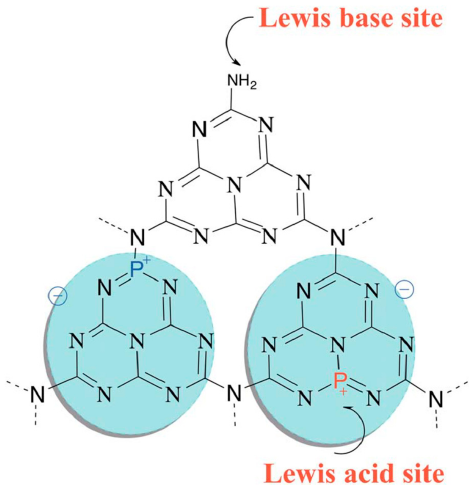
Figure 8. Scheme of a possible existing form of P atoms in the framework of of g-C 3 N 4 and its effect on the electronic and chemical properties of g-C 3 N 4 . The dark blue P atom refers to the corner site and the red one is the bay site. Reproduced from [126] Copyright (2015), with permission from The Royal Society of Chemistry.